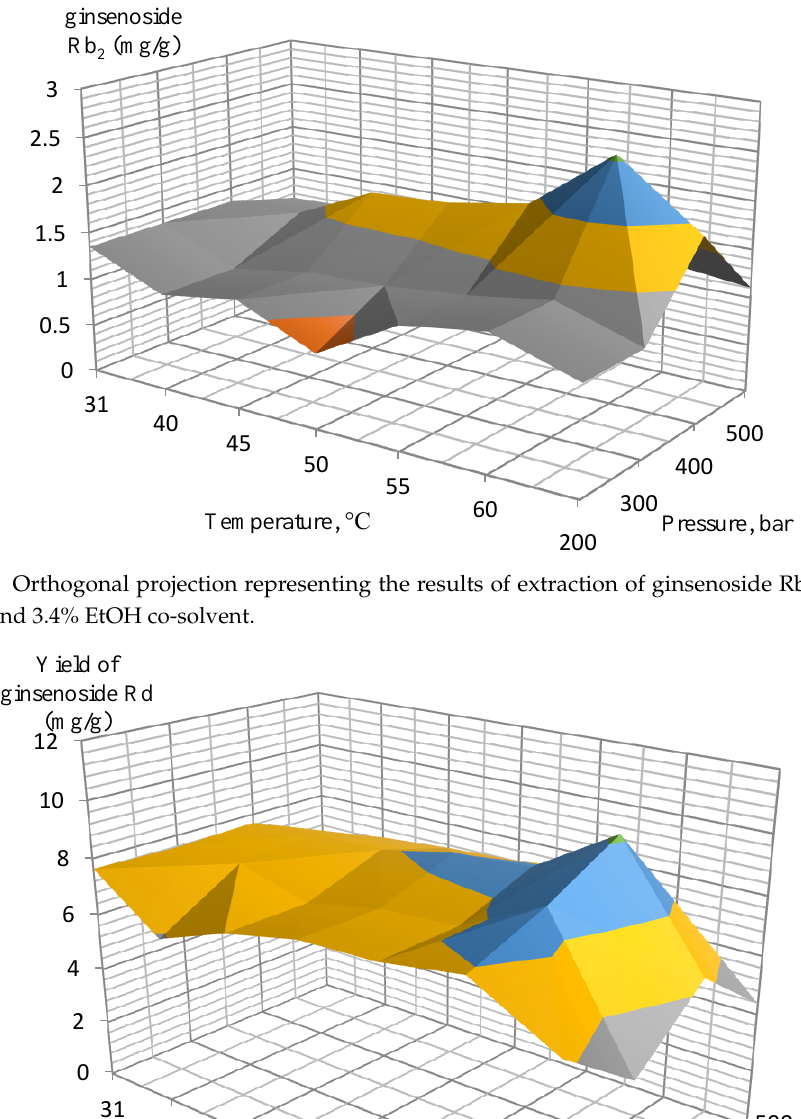
Figure 3. Orthogonal projection representing the results of extraction of ginsenoside Rd at 200 to 500 bar and 3.4% EtOH co-solvent.